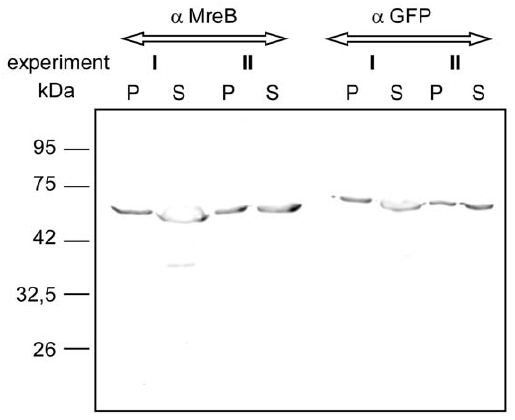
Figure 2. Sedimentation assays. Equal amounts of supernatant (S) or high speed pellet (P) fractions of S2 cells expressing YFP-MreB were loaded onto SDS-PAGE and tested via Western blotting, using anti MreB or anti GFP antibodies. Two independent experiments (each detected by the two different antisera) are shown to illustrate differences in expression